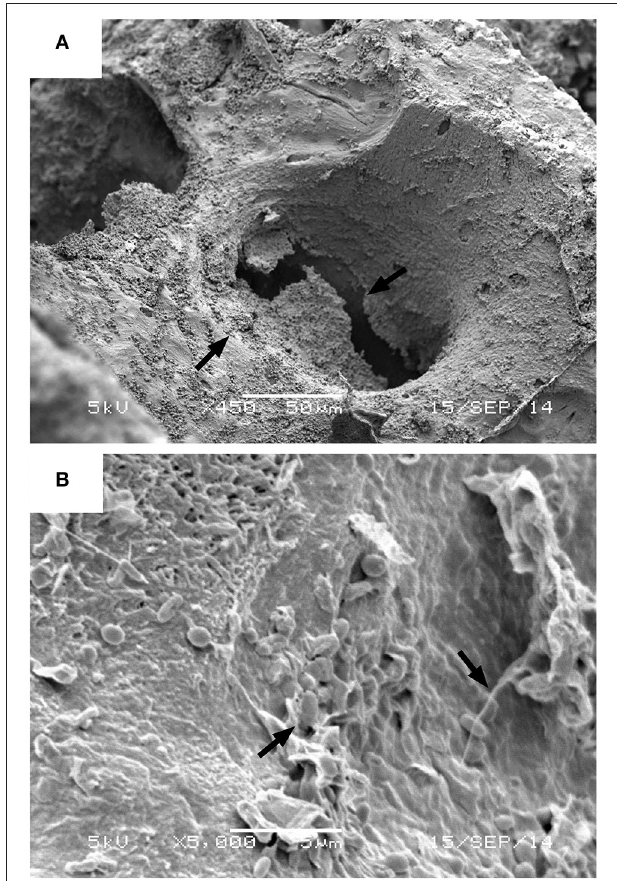
FIGURE 3 | Examples of biofilm morphology. (A) Arrows indicated the presence of encrusting biofilm on Haversian canal wall of a crushed Gallus gallus domesticus femur buried in the modeled crevasse splay deposit, with microbes resting in an undulatory exopolysaccharide (EPS) matrix. Image taken under HV71 at 450x magnification, 56 spotsize, with a 5 keV accelerating voltage (scale = 5 µ m). (B) Arrows indicating the presence of